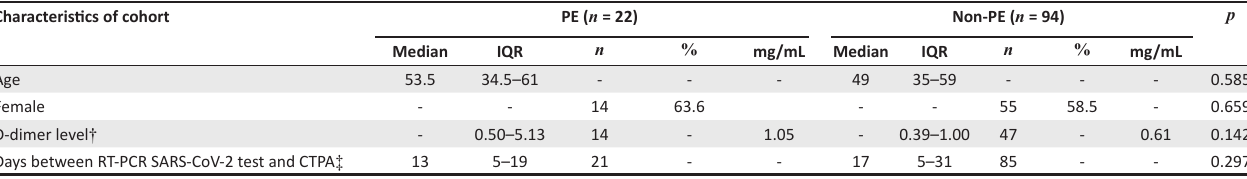
TABLE 3: Clinical characteristics of cohort.